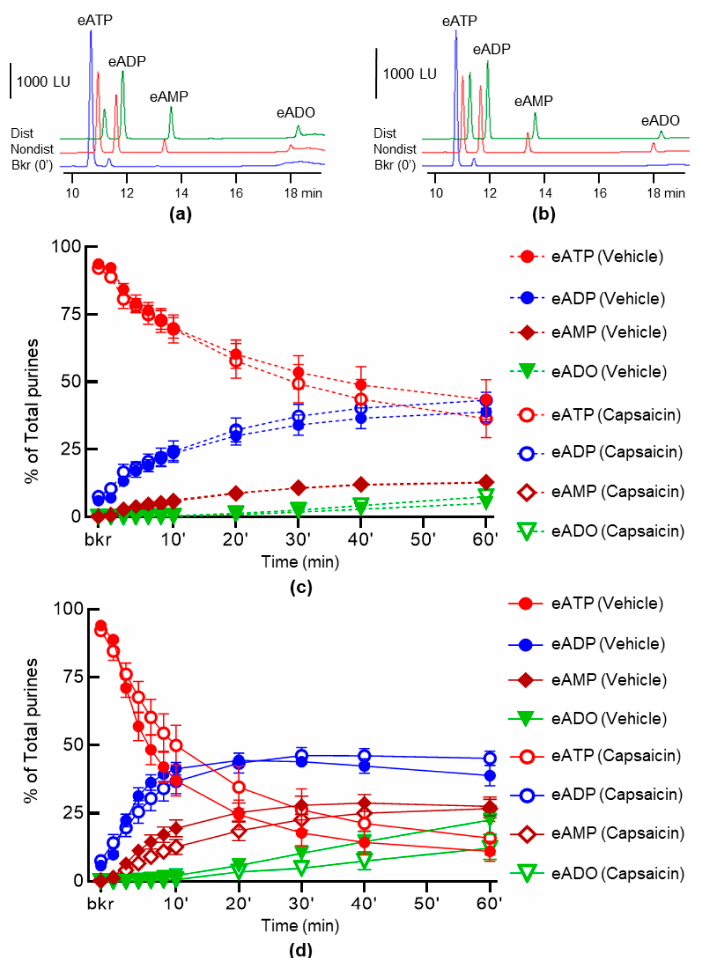
Figure 1. Effect of capsaicin on the hydrolysis of eATP by s-ENTDs released in cELS of detrusor- free bladder preparations. Original chromatograms of eATP in beaker (Bkr, blue, 0 ′ , no enzyme present) and at 60 min of enzymatic reaction in cELS of nondistended (Nondist, red) and distended (Dist, green) bladder preparations treated with vehicle ( a ) or capsaicin ( b ). LU, luminescence units. Note the decrease of eATP substrate and the increase or appearance of the 1,N 6 -etheno-products (e-products) 1,N 6 -etheno-ADP (eADP), 1,N 6 -etheno-AMP (eAMP) and 1,N 6 -etheno-ADO (eADO). Summarized data showing time-courses of eATP hydrolysis in cELS in the presence of vehicle (DMSO 0.1%, n = 7) or capsaicin 1 µM ( n = 5) in nondistended ( c ) and distended ( d ) bladders; n , number of bladder preparations. eATP, eADP, eAMP and eADO are presented as percentages of total purines (eATP + eADP + eAMP + eADO) present in reaction solutions. p > 0.05, vehicle control vs. capsaicin, two-way ANOVA with Sidak’s multiple comparisons tests.